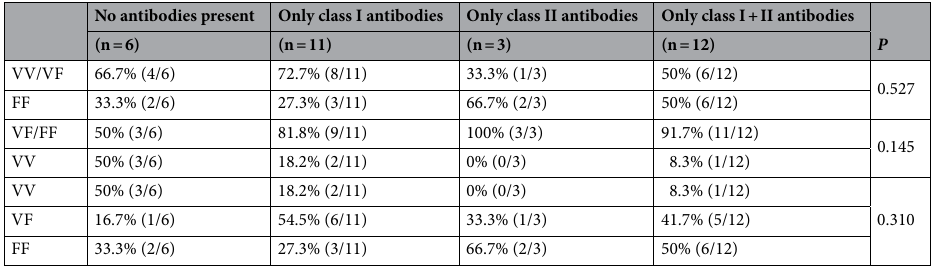
Table 4. Comparing frequencies of FCGR3A -p.176 genotypes in RPL women without antibodies versus women with class I antibodies versus women with class II antibodies versus women with class I and II antibodies. Class I and class II anti-HLA antibodies were tested in sera from 32 RPL women by Luminex Single Antigens and compared between groups of women where no antibodies were present, only class I antibody were present, only class II antibody were present and only class I and class II antibodies were present. Women were subsequently grouped based on FCGR3A -p.176 frequencies of (VV/VF) and (FF) or (VF/FF) and (VV) or FCGR3A -p.176 VV, VF and